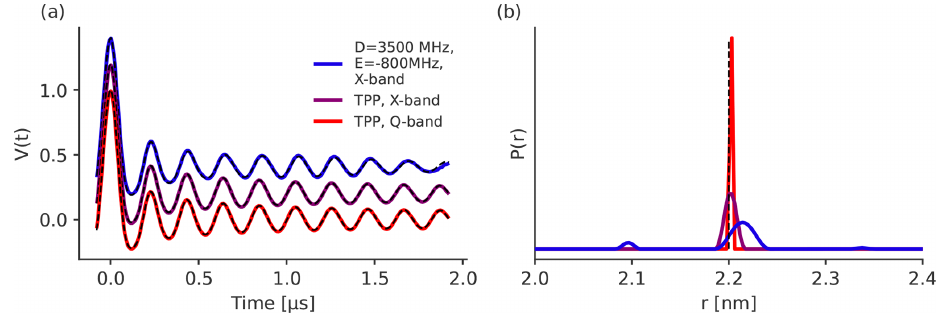
Figure 10. LiDEER simulations with the observer pulse placed on the Y + -peak of the EPR spectrum of the transient triplet label in different frequency bands and with different ZFS. The traces are shifted by 0.2 for better visibility. For the simulation in Q-band and the parameters of TPP, the magnetic field was set to 1.2097T and the observer frequency was set to 33.64GHz. For the simulations in X-band, the magnetic field was set to 0.33T. For the X-band simulation with the ZFS values of TPP, the observer frequency was set to 9.042GHz, and for the simulation with ZFS values of D = 3500 and E = − 800MHz, the observer frequency was set to 9.042GHz. The position of the observer and pump pulse with respect to the EPR spectrum is shown in Fig. S7a, c and e. The further parameters were P x = 0 . 33, P y = 0 . 41, P z = 0 . 26 and r = 2 . 2nm. The numerical simulations were fitted with Tikhonov regularization. The fits are shown as dashed black lines. Panel (b) displays the corresponding distance distribution. The true distance of r = 2 . 2nm is plotted as a dashed black line.